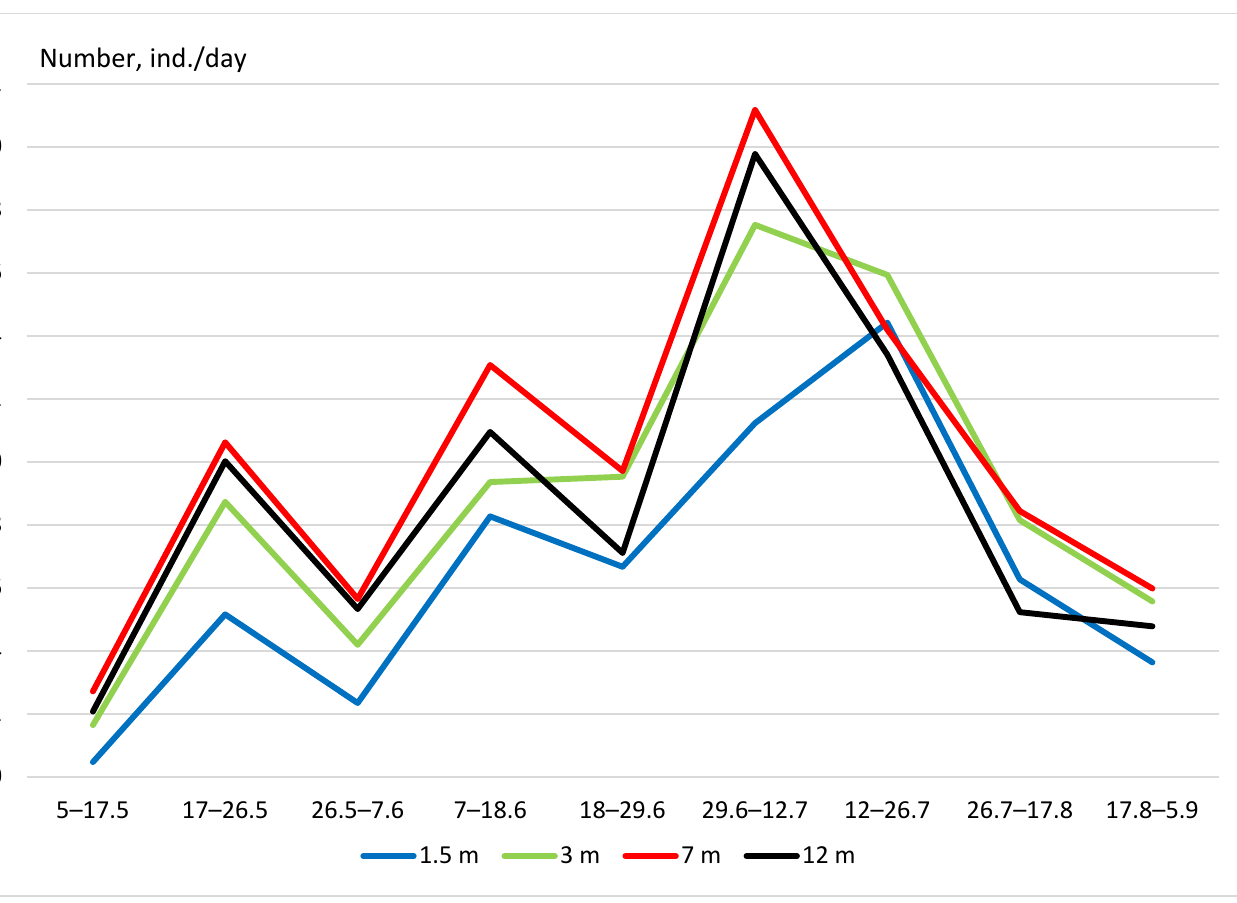
Figure 5. Seasonal dynamics of Lepidoptera abundance at various heights in pine forests.